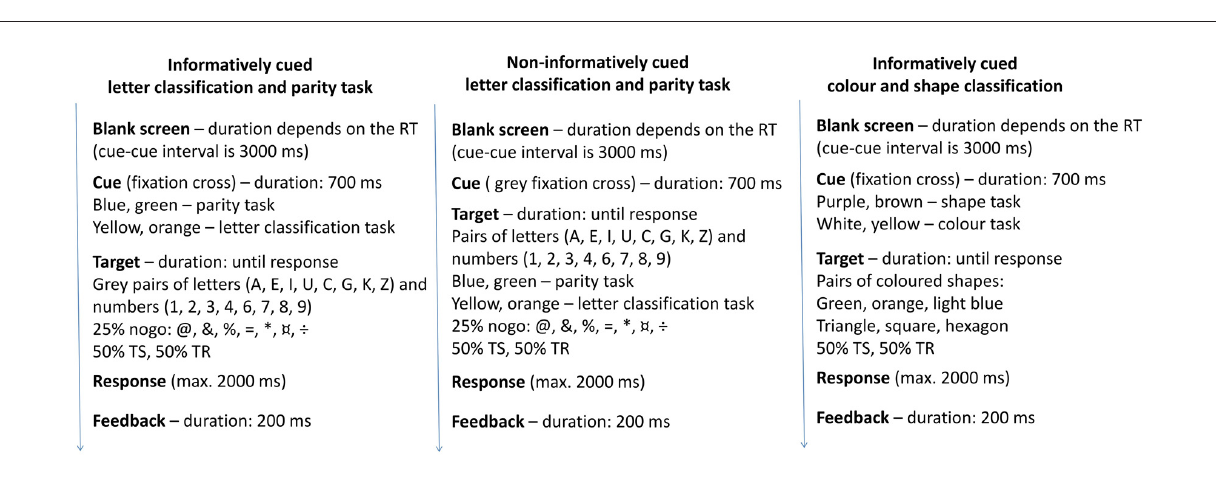
cue switching. Participants pressed the button of a gamepad with their left or right index finger and response mapping was